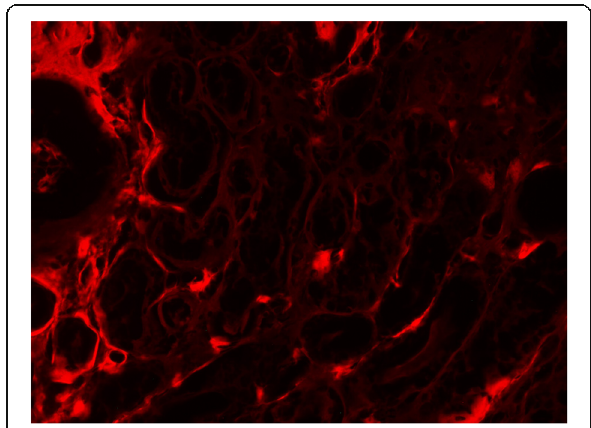
Fig. 2 Congo red examined with fluorescent microscope using a Texas-red filter